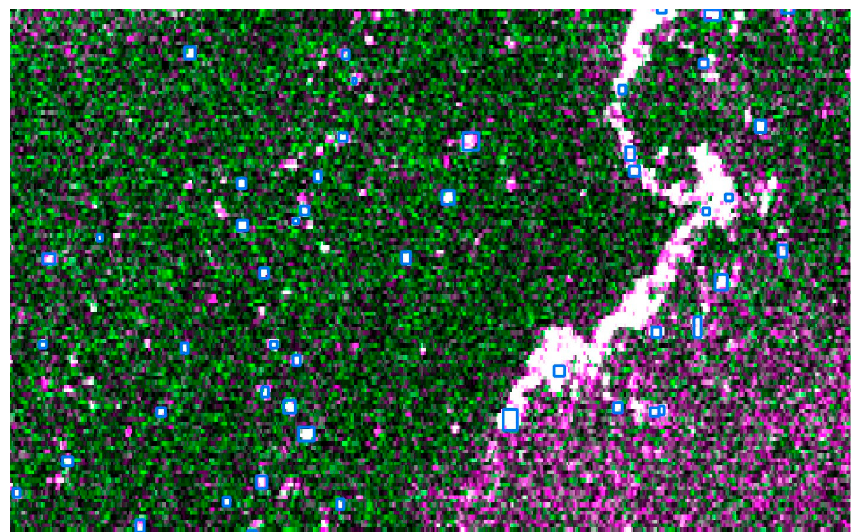
Figure 10. Example of icebergs detected with an adaptive thresholding algorithm in Sentinel-1 data.